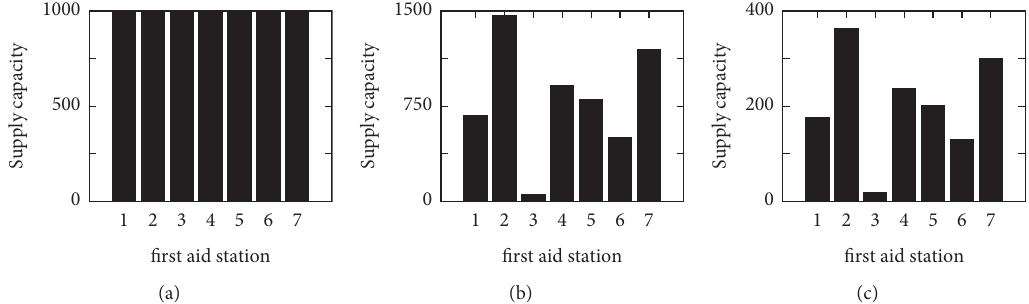
Figure 11: The different representations of first aid stations supply capacity. (a) Fixed numerical representation. (b) Number of beds representation. (c) SD3SFCA model representation.